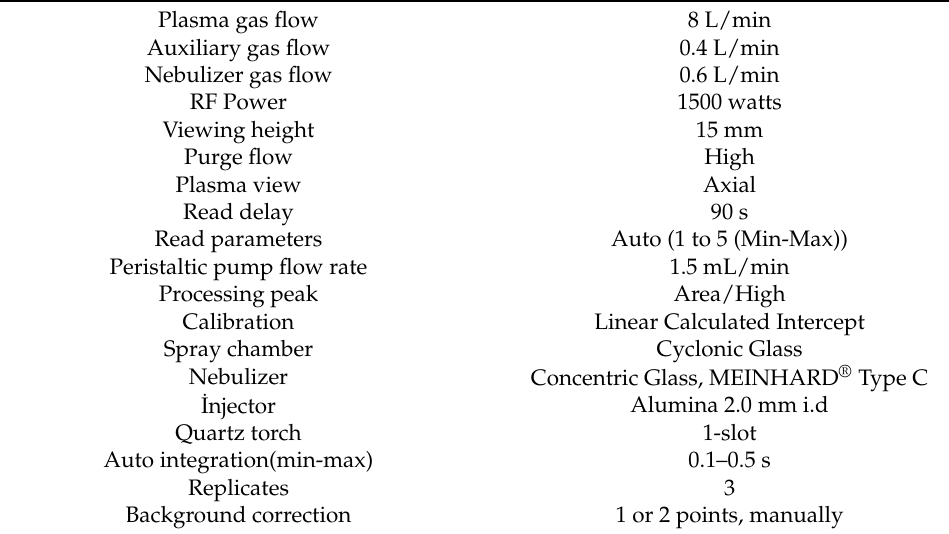
Table 3. Instrumental parameters for